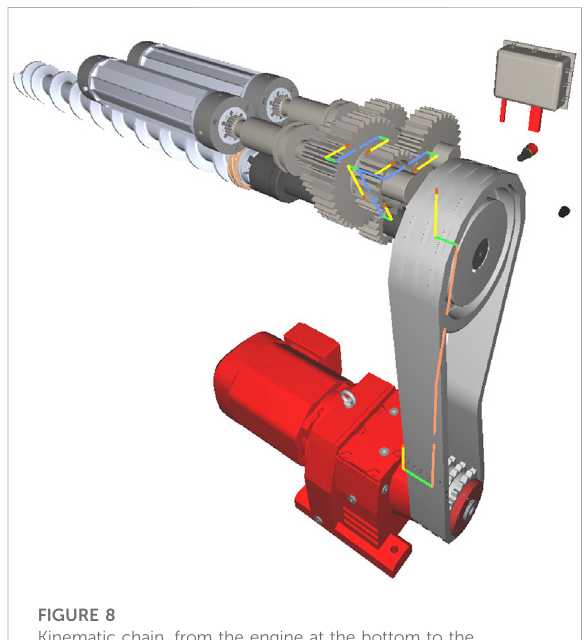
FIGURE 8 Kinematic chain, from the engine at the bottom to the gearing on top.